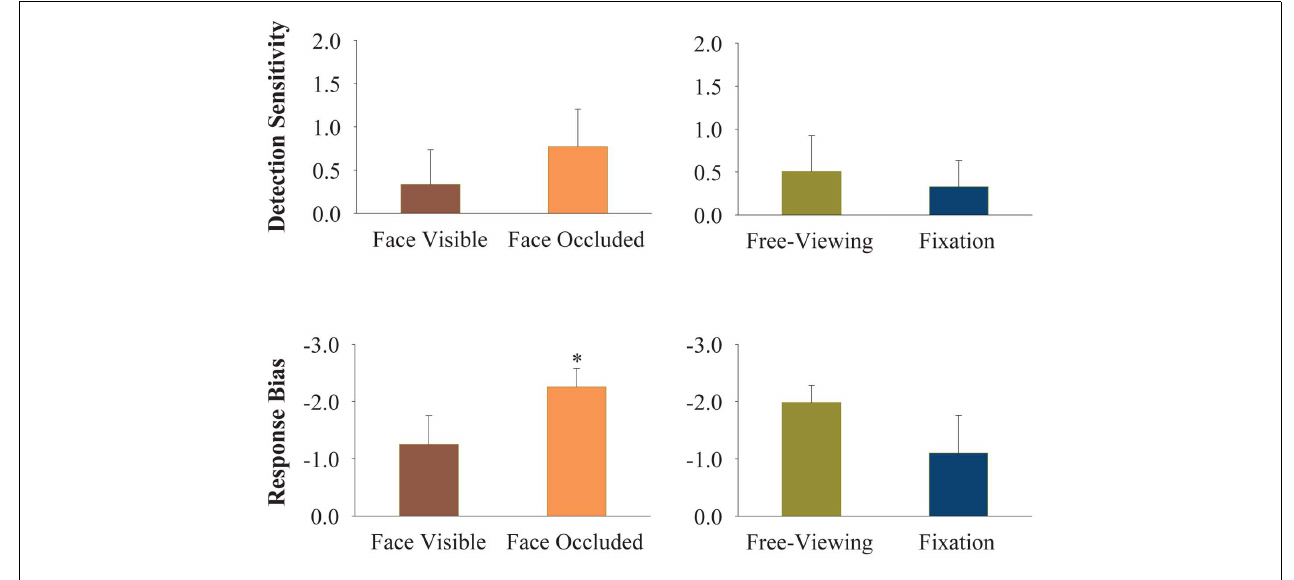
conditions. Right Column: Detection sensitivity and response bias of Free-viewing versus Fixation conditions. Error bars indicate SEM across subjects. *Paired t -test, p <